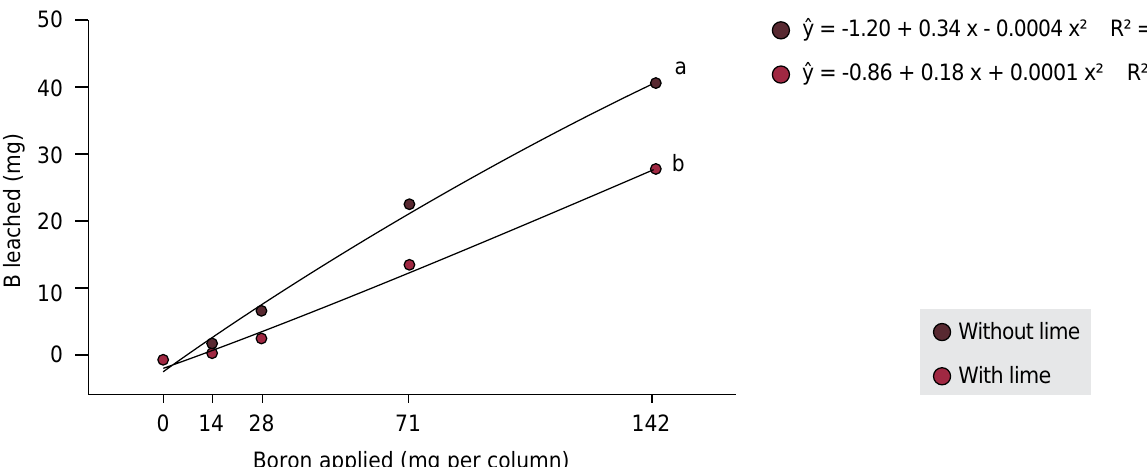
Figure 1. Total amount of boron leached after 15 percolations with distilled water as affected by liming and rates of boron applied. Average of three replications. Regression curves followed by different letters differ by the F-test at the 5 % significance level. **: significant at 1 %.